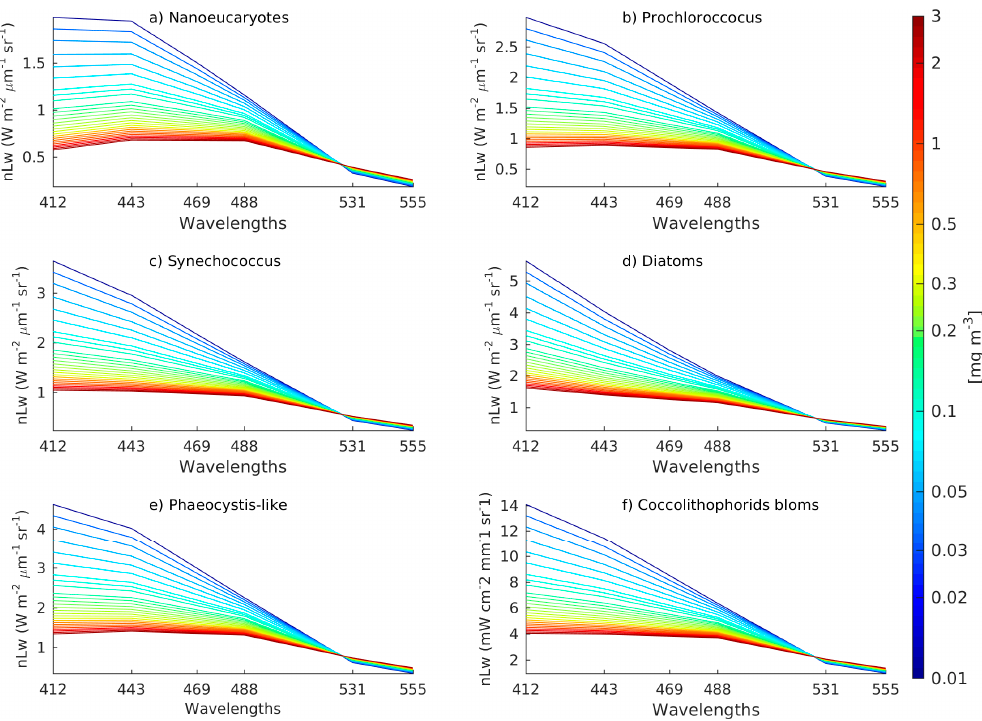
Figure A1. The typical nLw radiances for PFTs in environments with Chl-a concentrations in the range between 0.01 and 3 mg·m − 3 , contained in the Rs synthetic matrix.